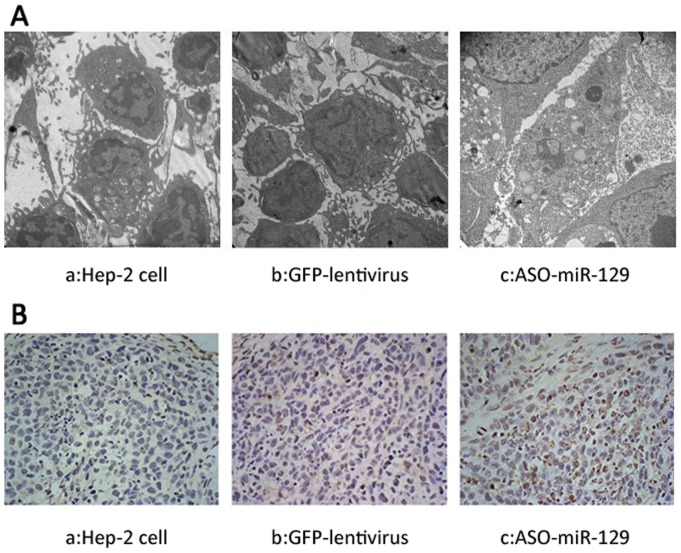
Ultrastructure of tumour cells by transmission electronic microscopy and detection of apoptosis using TUNEL assay.(A) Tumour cells exhibited the characteristic morphology of apoptosis: chromatin margination, condensation of the nucleus, and apoptotic bodies (c) after treatment of ASO-miR-129-5p, but not tumour cells treated with GFP (b) or untreated Hep-2 cells (a) (original magnification: 12000×). (B): The percentage of apoptotic cells in the ASO-miR-129-5p group (c) was significantly higher (39.01±2.32%) than in untreated group (a) (4.96±3.17%) or GFP control group (b) (6.4±1.81%). (P<0.05, original magnification: 400×)